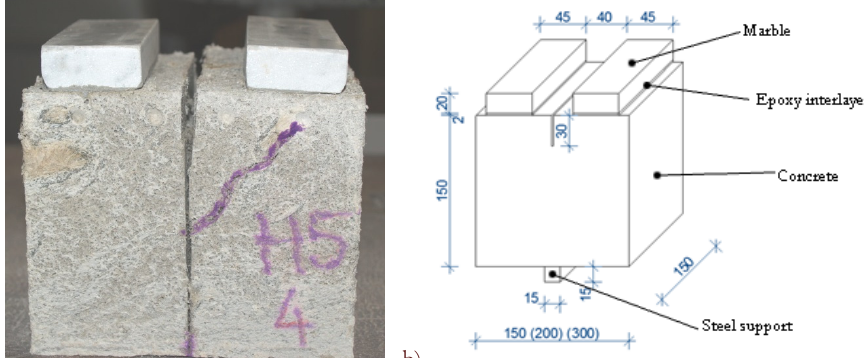
Figure 1: Wedge splitting specimen: a) photo and b) sketch: where the rectangular groove is formed by two marble plates glued on the upper side of the